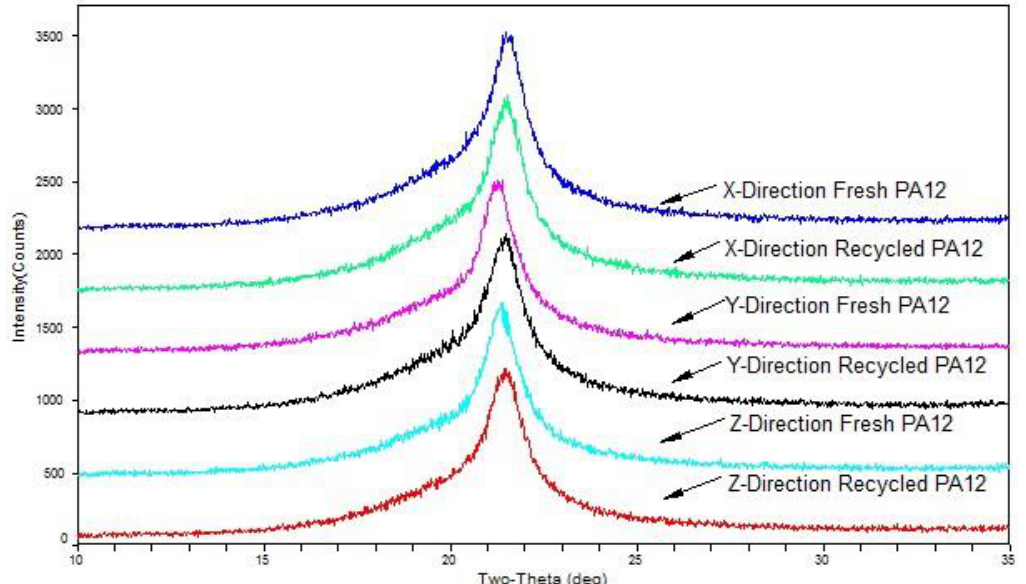
Figure 8. XRD pattern of different build orientations printed from filaments made of recycled PA12 powder and fresh PA12 pellets.